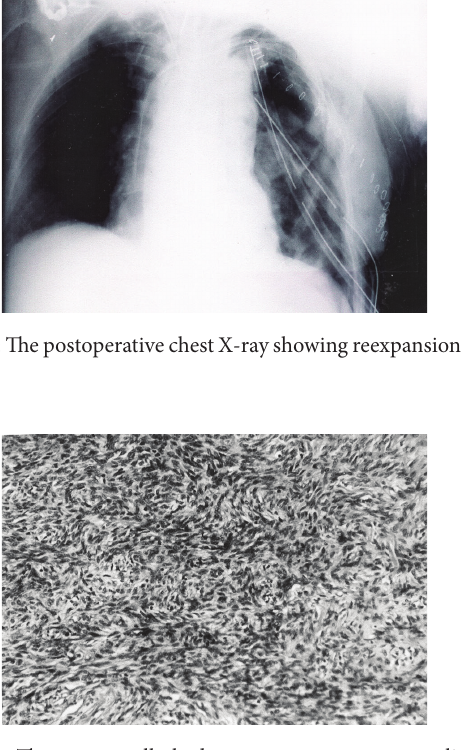
Figure 4: The tumor cells had a wavy appearance; a palisading arrangement was focally observed (H&E ×